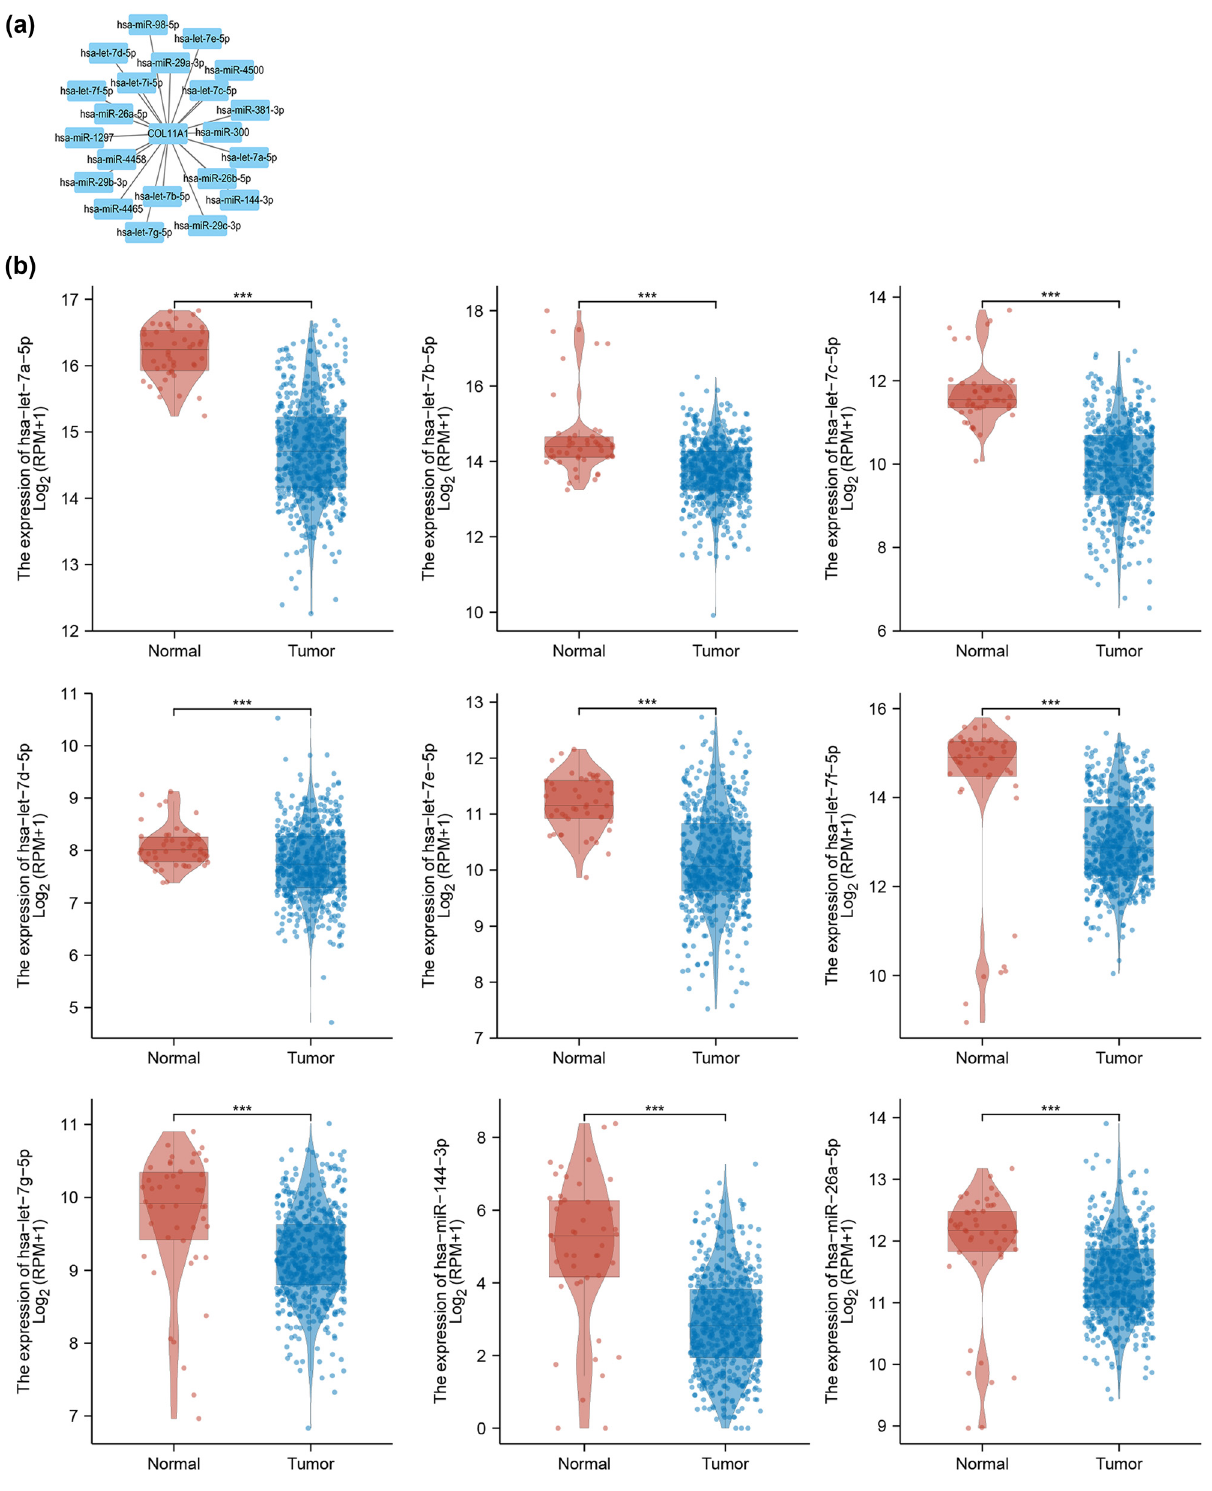
Figure 7: COL11A1 - related miRNAs. TargetScan online database was used to predict the potential miRNAs regulators of COL11A1 ( a ) . A total of nine miRNAs ( hsa - let - 7a - 5p, hsa - let - 7b - 5p, hsa - let - 7c - 5p, hsa - let - 7d - 5p, hsa - let - 7e - 5p, hsa - let - 7f - 5p, hsa - let - 7g - 5p, hsa - miR - 144 - 3p and hsa - miR - 26a - 5p ) expression were signi fi cantly downregulated in LUAD tissues compared with normal tissues in TCGA database ( b ) . *** P < 0.001 compared with control